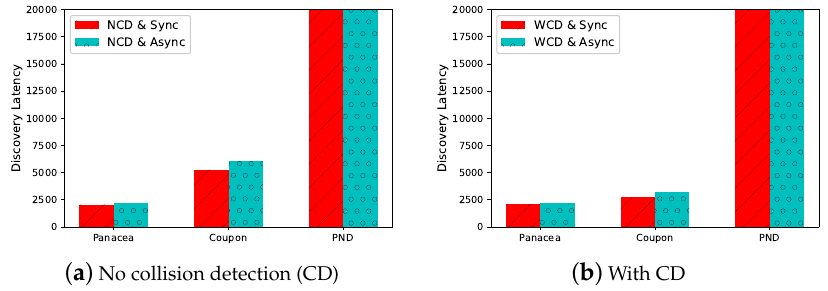
Figure 3. Panacea -NCD and Panacea -WCD have the lowest discovery latency under both synchronous and asynchronous scenarios when p n = 0.1, N = 1000.